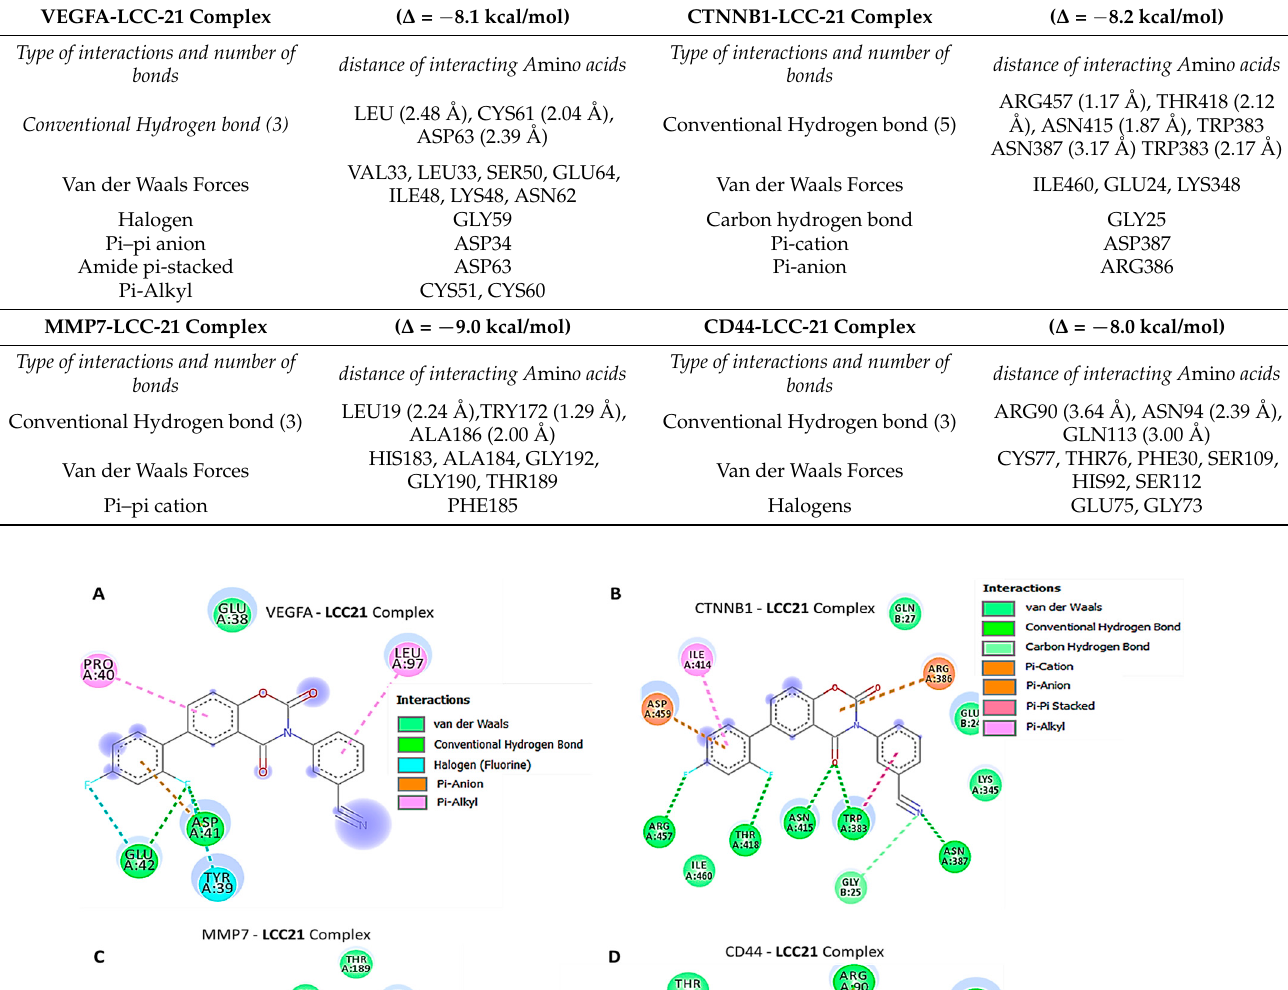
Table 2. Analytical summary table showing interactions of LCC-21 with VEGFA/CTNNB1/MMP7/CD44 .